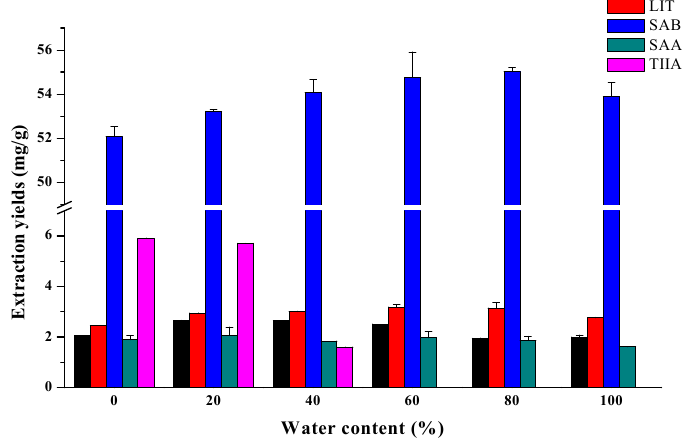
Figure 2. Effect of the water content (temperature = 50.0 ◦ C, time = 10.0 min, microwave power = 800 W, Figure 2 Effect of the water content (temperature = 50.0 °C, time = 10.0 min, microwave power = 800 solid/liquid ratio = 0.005 g · mL − 1 ). W, solid/liquid ratio = 0.005 g ∙ mL ‐ 1 ).